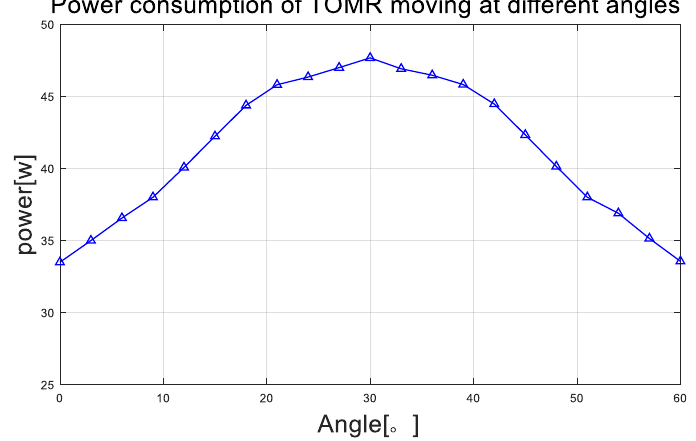
Figure 8. Power consumption of TOMR moving at different angles.